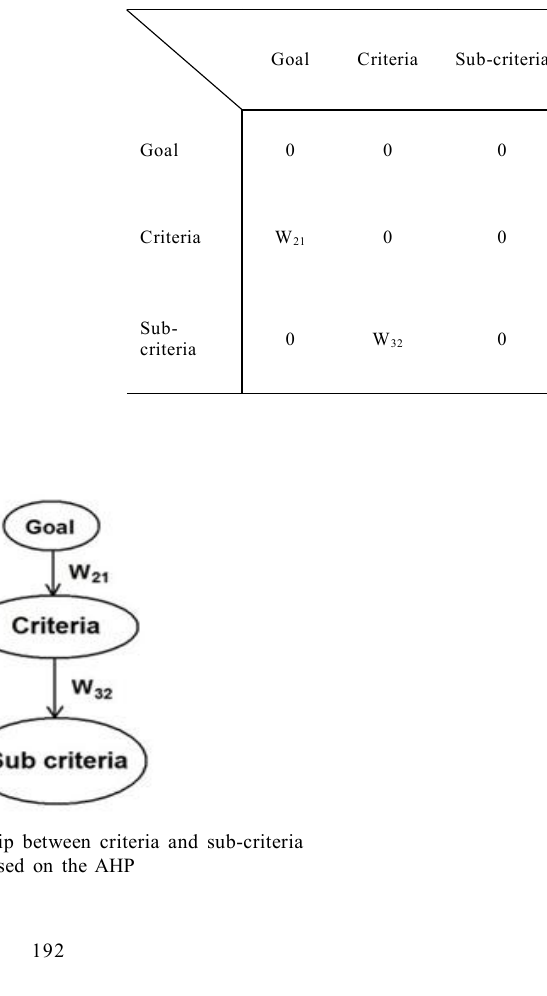
Table 2: Saaty’s fundamental scale (Saaty and Vargas, 2006) Intensity of